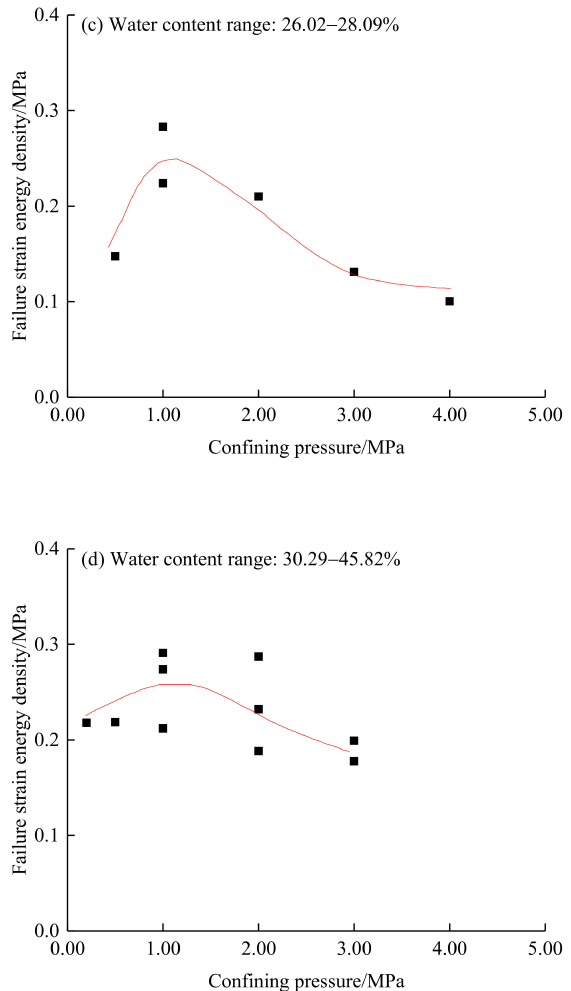
Figure 6. Failure strain energy density vs. confining pressure (( a ) the water content range: 13.25–19.81%, ( b ) the water content range: 21.16–25.76%, ( c ) the water content range: 26.02–28.09%, ( d ) the water content range: 30.29–45.82%; the black squares represent test data points, and the red lines are the change trend lines given according to the black